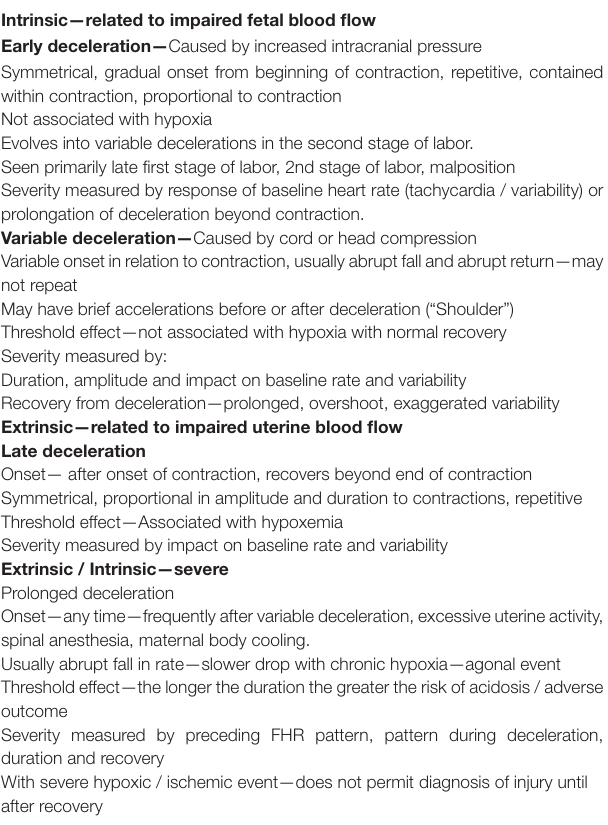
TABLE 2 | Characteristics of decelerations.